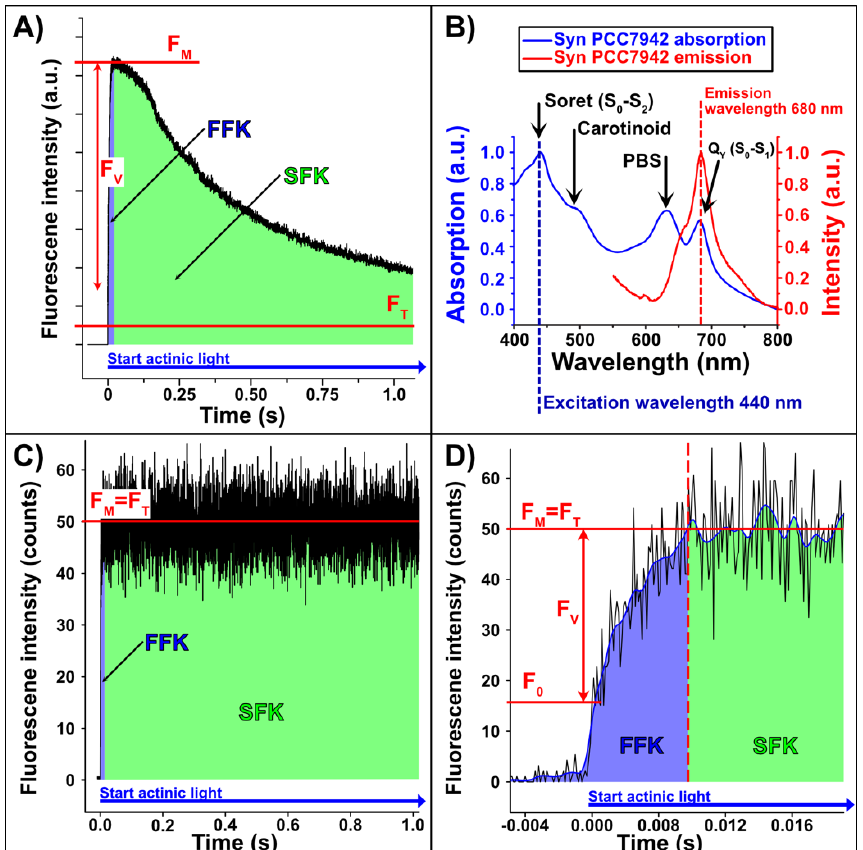
Figure 1. ( A ) Illustrative example of a fluorescence intensity time trace of a S. elongatus population (without any special treatment) excited with saturating light intensity (blue arrow). Shown in red: the maximum fluorescence intensity (F M ) and the terminal fluorescence (F T ) intensity according to the Kautsky effect. The blue area indicates the temporal range of the fast fluorescence kinetics (FFK), and the green area indicates the range of the slow fluorescence kinetics (SFK). ( B ) Normalized fluorescence (red) and absorption (blue) spectra of S. elongatus measured in BG11 medium, taken from [8]. The bacteria were excited with 440 nm light (blue dashed line). This spectrum was acquired with a conventional UV/VIS spectrometer. In contrast to the following measurements, no spectral filters were used for wavelength selection. The bacteria have both absorption and emission maxima at approx. 680 nm (red dashed line). ( C ) Fluorescence intensity time trace of S. elongatus after treatment with 3-(3,4-dichlorophenyl)-1,1-dimethylurea (DCMU). By spiking with DCMU, F T no longer decreases to the same level as shown in ( A ), because electron transport between PS2 and PS1 is blocked, and the excitation energy is released almost exclusively by fluorescence. In this case, the terminal fluorescence (F T ) is equal to the maximum fluorescence (F M ). ( D ) Expanded section of ( C ) to determine the sudden fluorescence increase F 0 and the maximum fluorescence F M . These values are used to quantify the quantum yield ( Φ maxPS2 = 0.7 for this particular